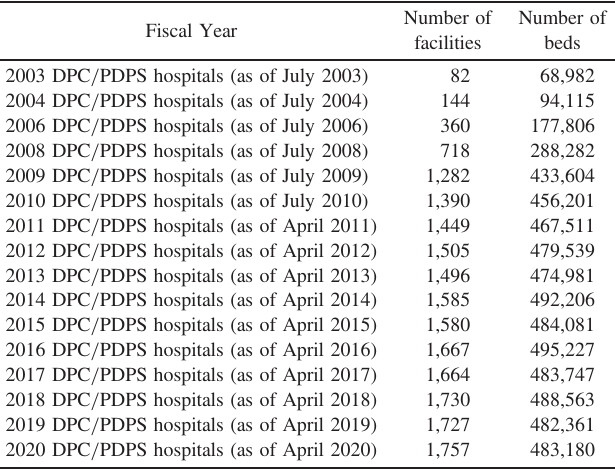
Table 3. Changes over time in number of hospitals / beds subject to DPC-based Per-Diem Payment